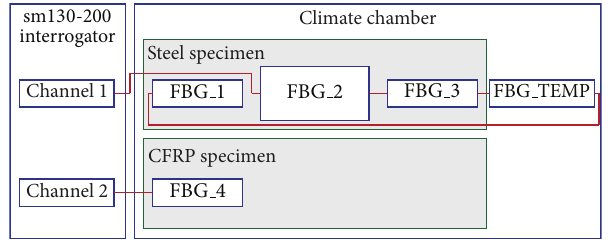
Figure 1: Layout of the specimens used in the study.